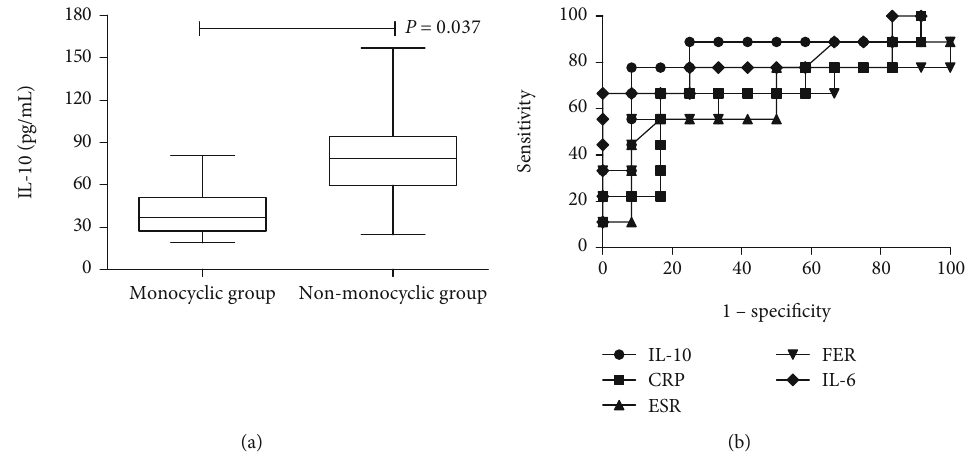
Figure 4: Correlation between serum IL-10 and disease courses. (a) Comparison of IL-10 levels among patients with SoJIA with monocyclic pattern and nonmonocyclic pattern. (b) ROC curves of IL-10, CRP, ESR, FER, and IL-6 for predicting disease course in